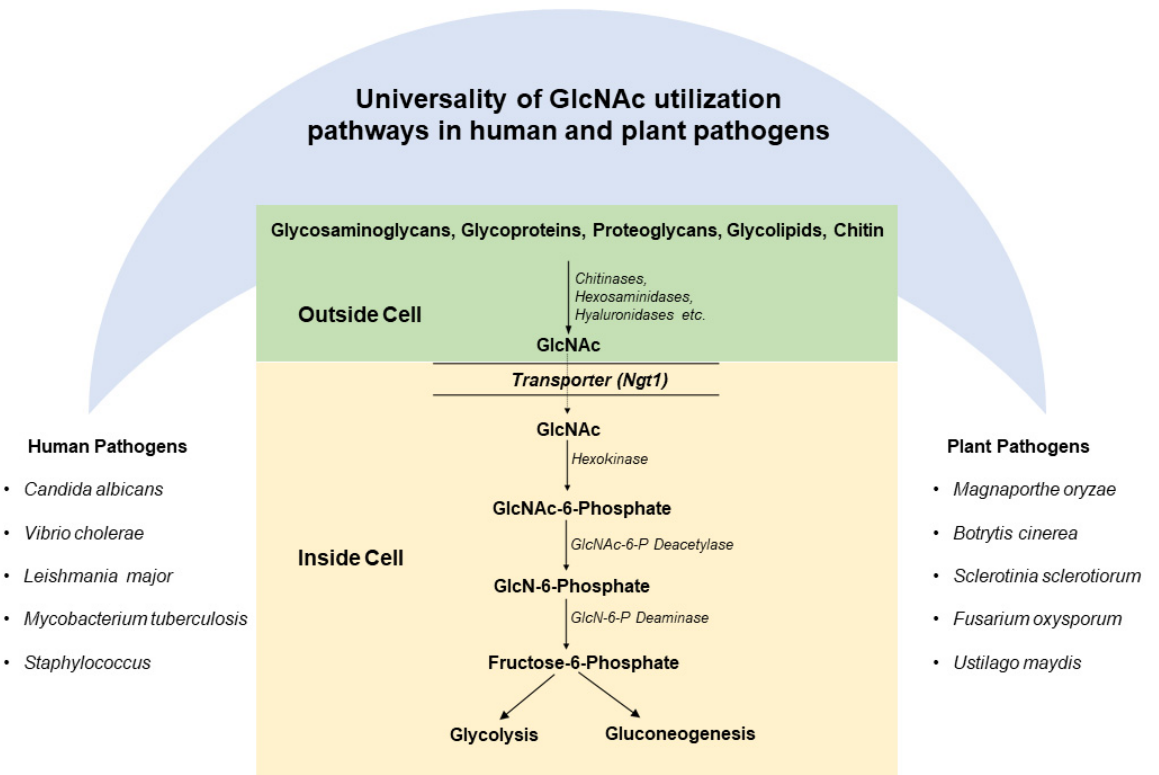
Figure 3. GlcNAc catabolic pathway: glycosaminoglycans, glycoproteins, proteoglycans, glycolipids, and chitin are the major sources of GlcNAc. Enzymes such as chitinases, hexosaminidases, hyaluronidases, etc., release free-GlcNAc from these macromolecules, which are taken up by the pathogens. The GlcNAc catabolic pathway involves three enzymes: hexokinase, GlcNAc-6-P deacetylase, and GlcNAc-6-P deaminase, which act sequentially to convert GlcNAc into fructose-6- phosphate.